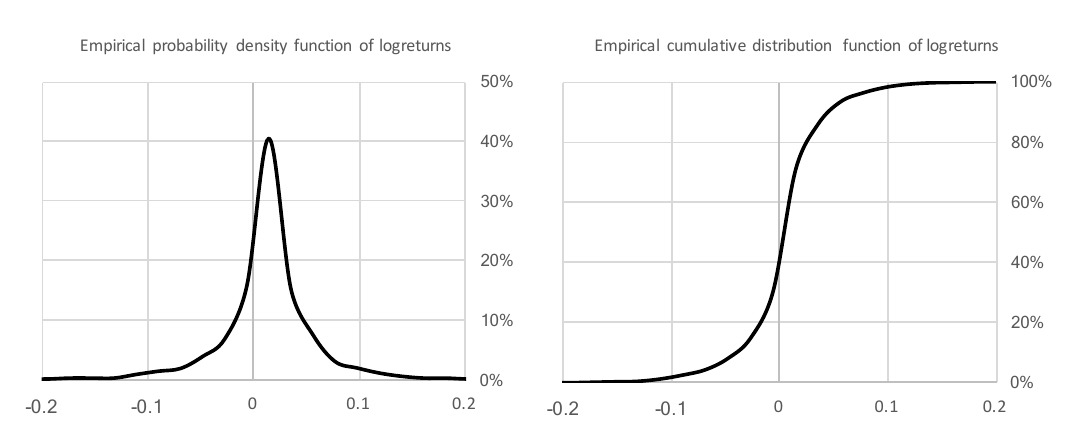
Figure 2. Bitcoin’s daily close-to-close logreturns and entropies.